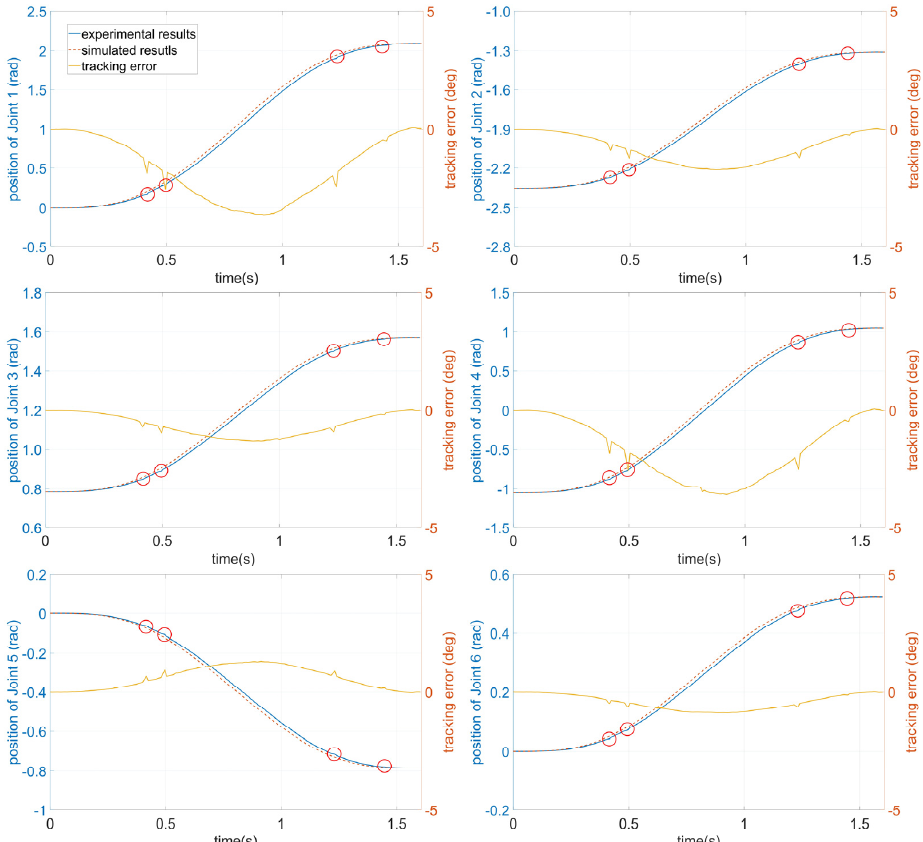
Figure 8. Measured joint trajectories for the adjusted task. Table 5. Mean values of maximum absolute tracking errors and terminal errors with their variances of all joints.